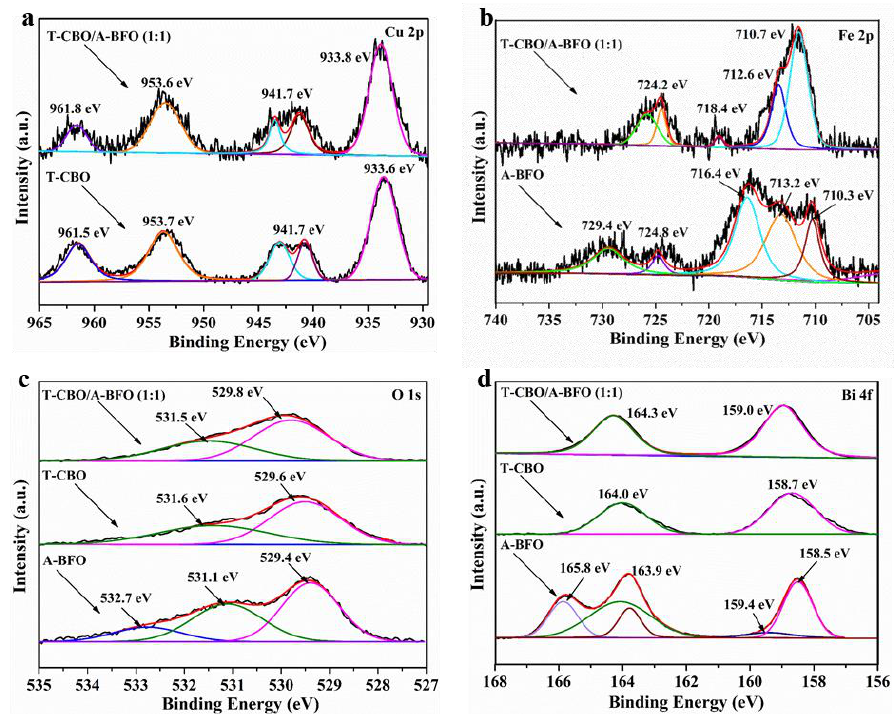
Figure 4. XPS high-resolution spectra of ( a ) Cu 2p, ( b ) Fe 2p, ( c ) O 1s, and ( d ) Bi 4f for the T-CBO, A-BFO, and T-CBO/A-BFO (1:1). The arrow pointed to the curves of different samples, and specific XPS peaks in case of overlapping.